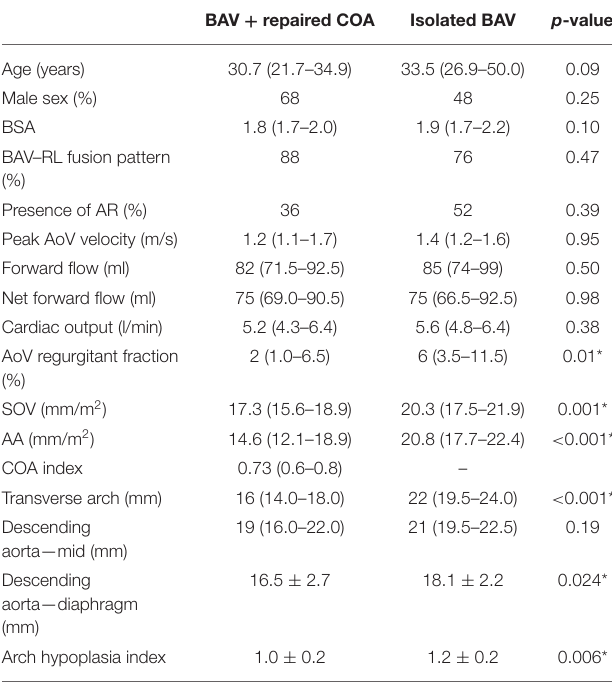
TABLE 1 | Demographic characteristic, anatomical, and functional data.